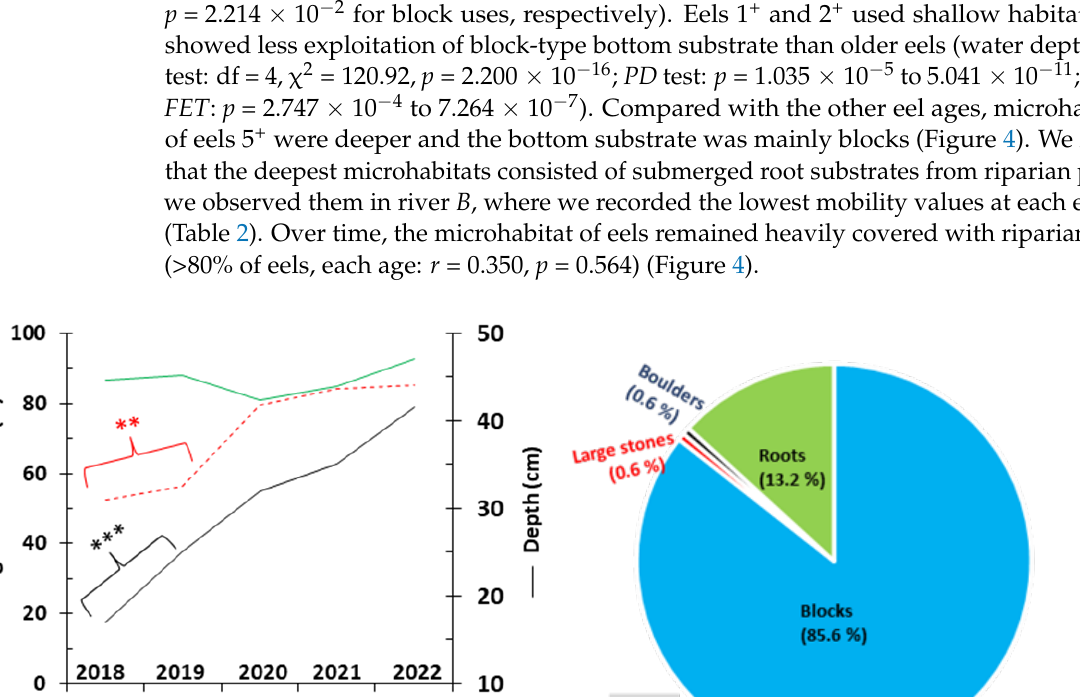
Table 2. Mobility of eels 5 + (based on the spring 2022 telemetry session) according to both age and total length at the time of tagging and characteristics of their microhabitats. The values are the mean and standard error. RO means boulders, B indicates block, PG refers to large stones and RA is submerged roots. The rivers are A , B , C , D , E and F . Floods occurred in July 2021 and eels 4 + were tagged in autumn 2021 after flooding events.